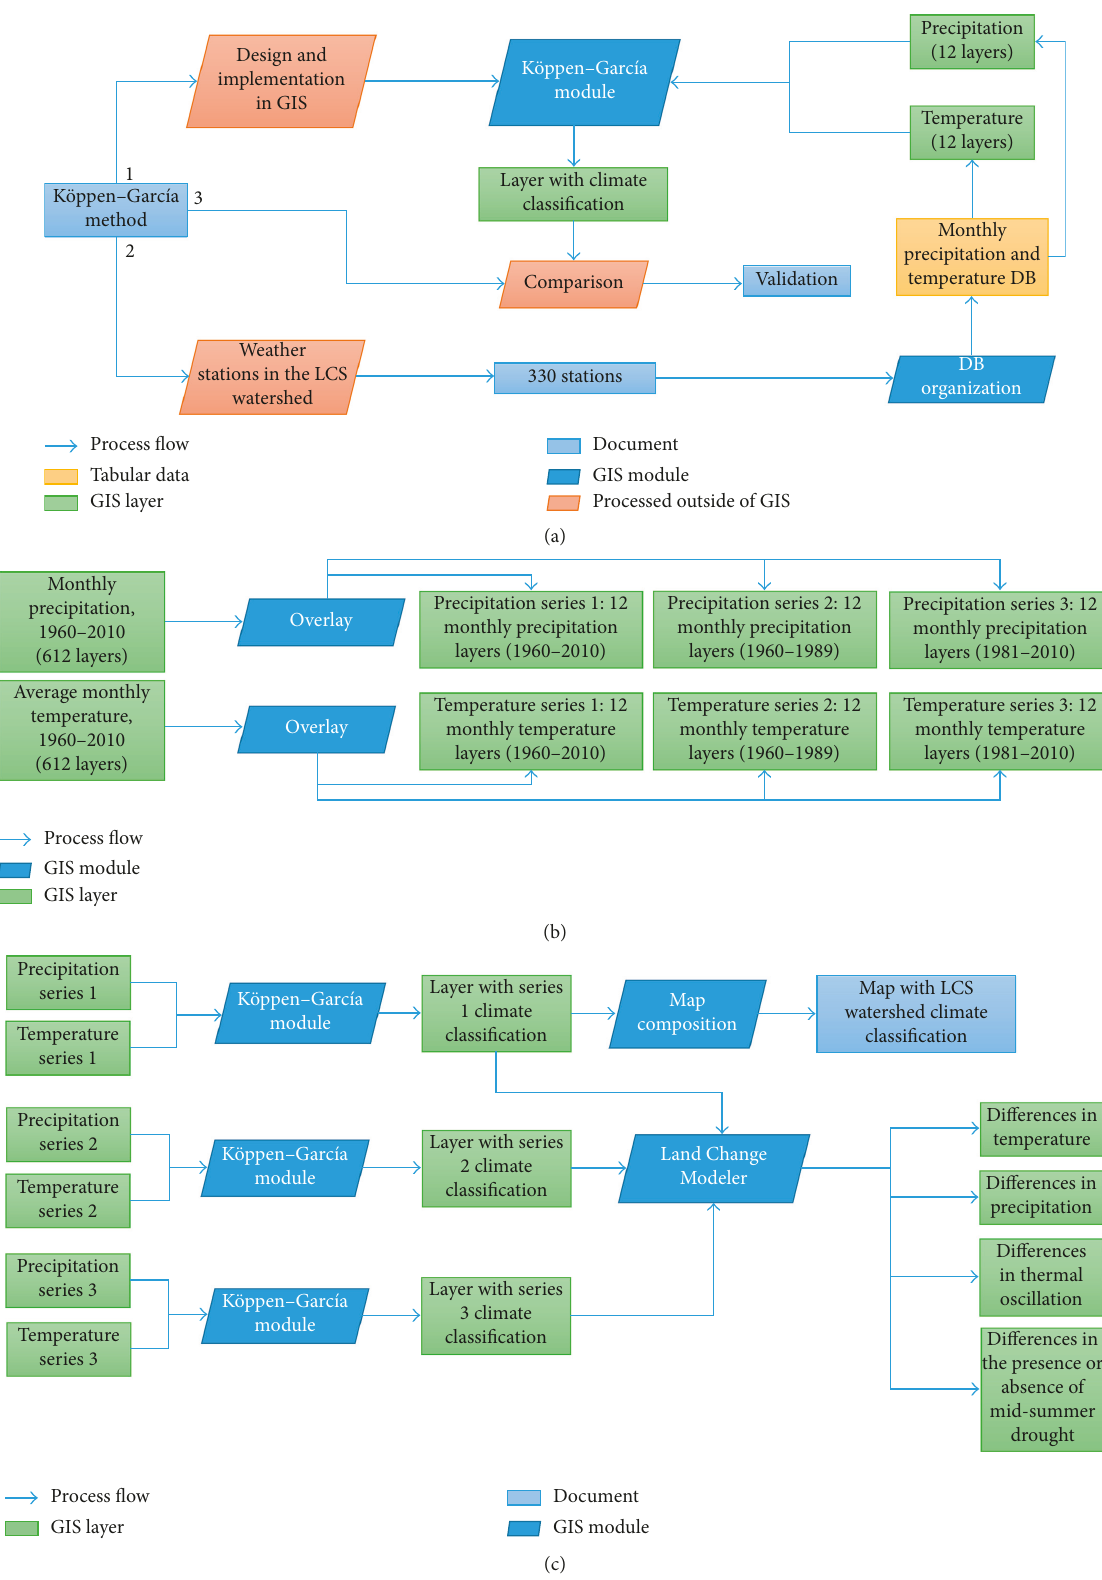
Figure 2: Procedures for (a) automating the K¨oppen–Garcia climate classification method in a GIS module, (b) obtaining three series of monthly rainfall and temperature layers for the Lerma-Chapala-Santiago watershed (1960–2010, 1960–1989, and 1981–2010), and (c) classifying climate per time